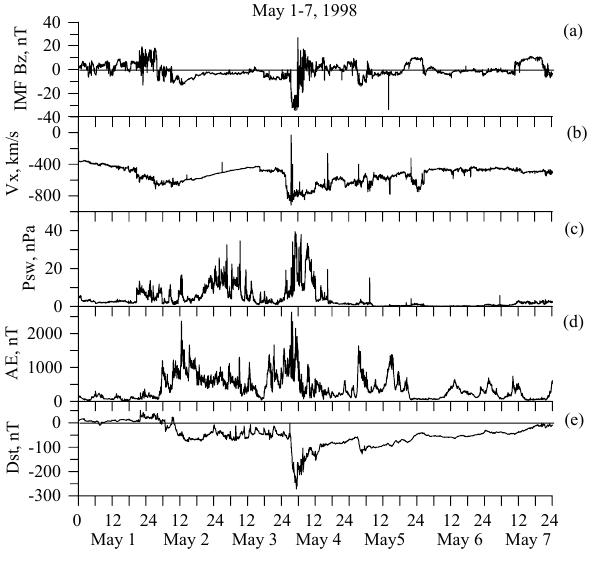
Fig. 2. D st -dependent contributions in percents to the ring current energy (1–200keV) from protons with low (0–20keV, blue trian- gles, upper panels), medium (20–80keV, green diamonds, middle panels) and high (80–200keV, red rectangles, bottom panels) for ( a ) initial, ( b ) main and ( c ) recovery storm phases calculated us- ing Polar CAMMICE/MICS measurements during 27 storms dur- ing 1996–1998. The linear fits are shown by solid black lines in all panels.